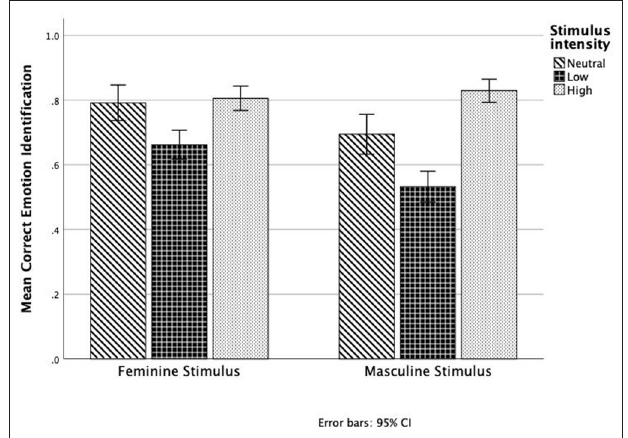
FIGURE 4 | Proportion of correct emotion identification by stimulus gender and intensity.